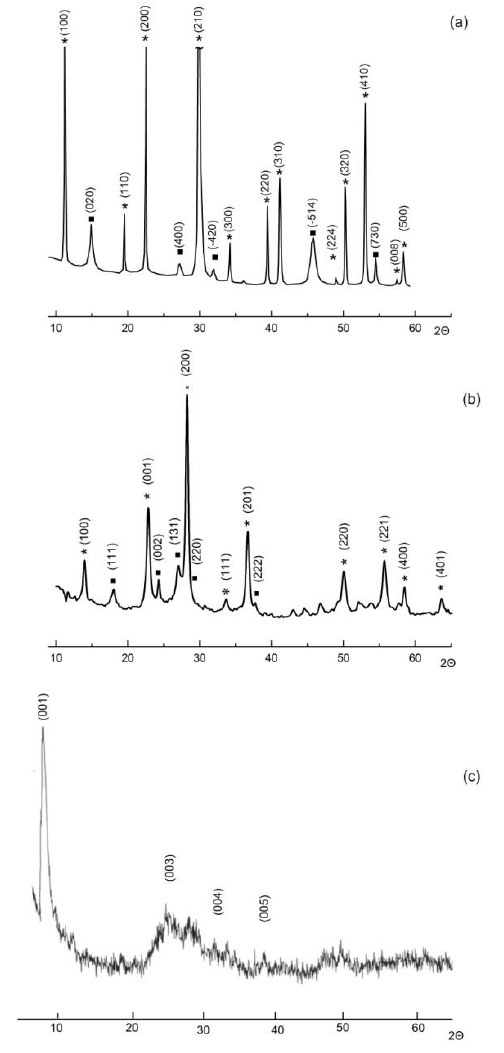
Figure 3. XRD patterns of ( a ) h -MoO 3 , ( b ) h -WO 3 , and ( c ) monoclinic V 2 O 5 xerogel crystallites used for preparation of heterostructure photocatalysts. Hexagonal MoO 3 and WO 3 (marked at the pattern with asterisks) contain an admixture of monoclinic MoO 3 ·H 2 O and orthorhombic WO 3 ·0.33 H 2 O (marked with squares). θ is the diffraction angle.